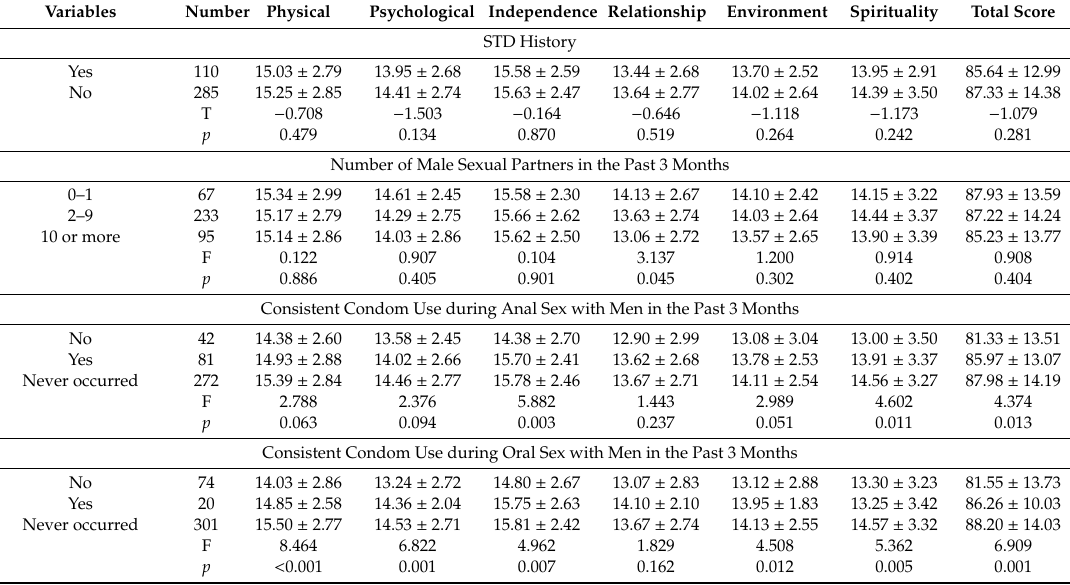
Table 3. Sexual factors and their associations with quality of life ( n =